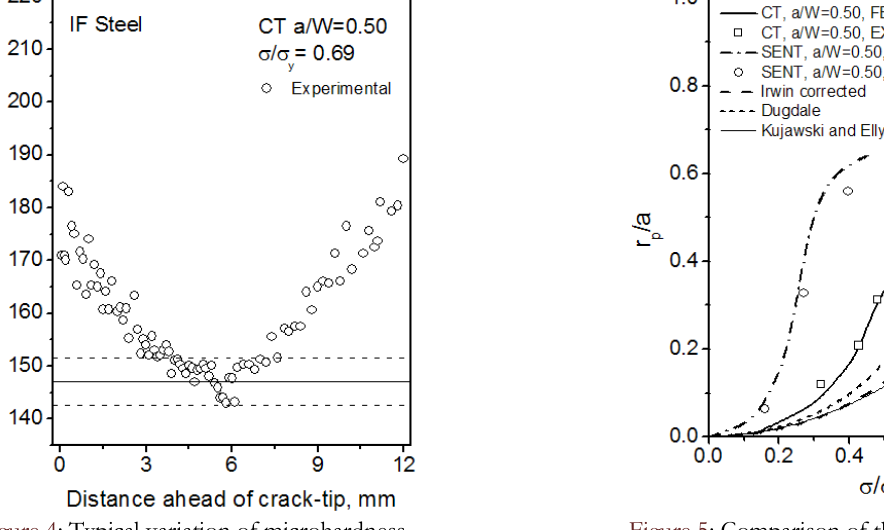
Figure 5: Comparison of the experimental and FEA results with various analytical methods.